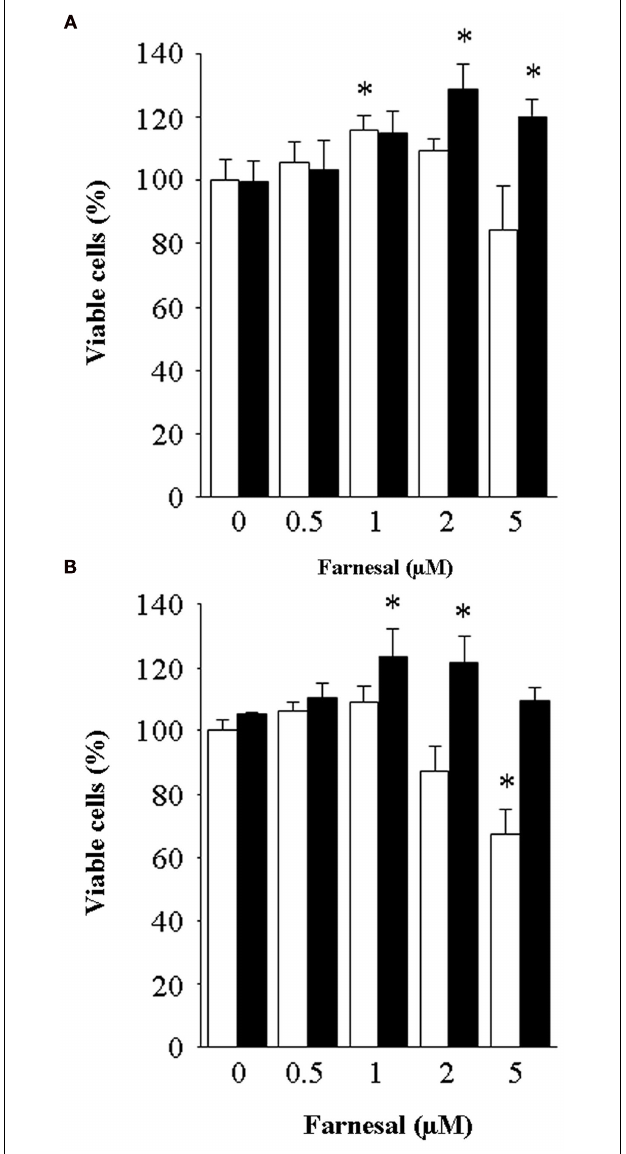
FIGURE 5 | Facilitation of proliferation potential of HT29 cells by treatment with farnesol (A) and farnesal (B). HT29 cells were pretreated for 2h without ( (cid:3) ) or with 25 μ M 4-hydroxyacetophenone ( (cid:2) ), and then treated for 48h with the indicated concentrations of farnesol or farnesal. The viable cell number was evaluated as noted in Figure 4 .Value is normalized to those in the control cells incubated without both isoprenoids and 4-hydroxyacetophenone, and expressed as the mean ± SD of three independent experiments. *Significant difference ( p < 0.05) from the control cells.